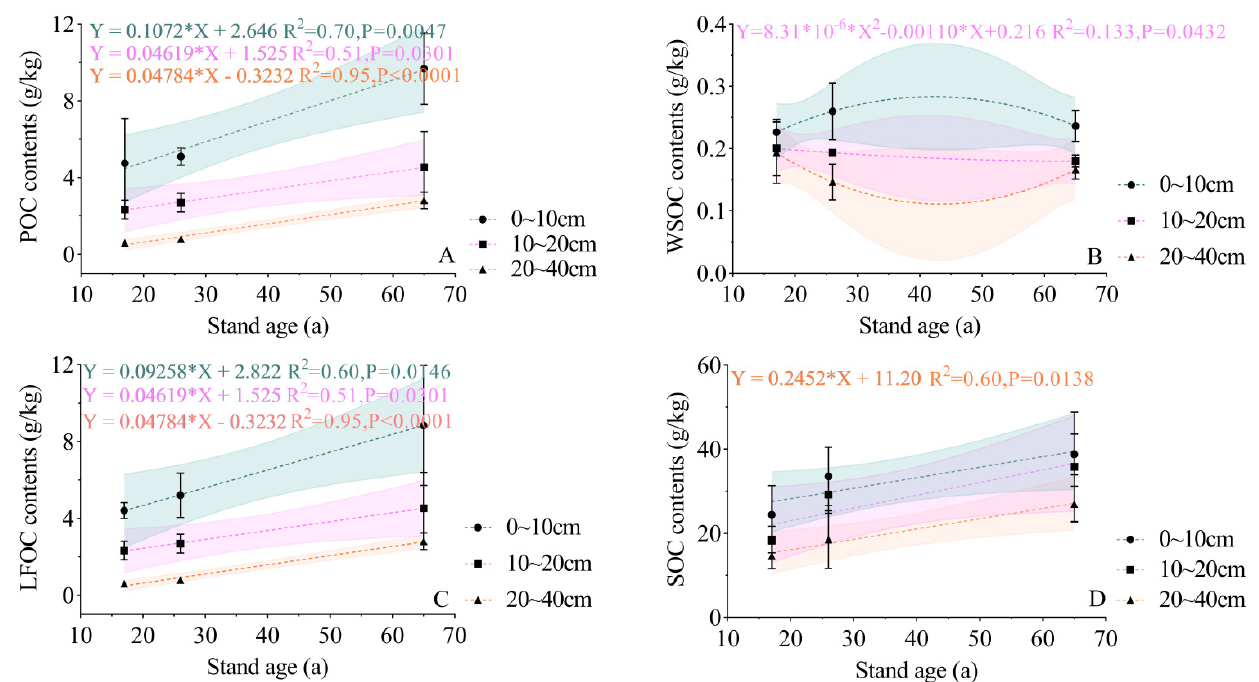
Figure 2. Variations in soil labile organic carbon with stand age. particulate organic fraction (POC, ( A )); soil water-soluble organic carbon (WSOC, ( B )); light fraction organic carbon (LFOC, ( C )); soil organic carbon (SOC, ( D )) (mean ± SD, n = 3).